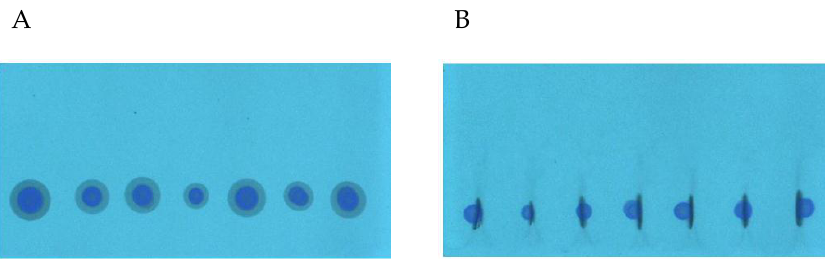
Figure 2. The mixture (methanol sample) chromatograms: ( A ) after sample application; ( B ) after spot narrowing procedure. HPTLC Silica gel 60 F254 (Merck), mobile phase: methanol.